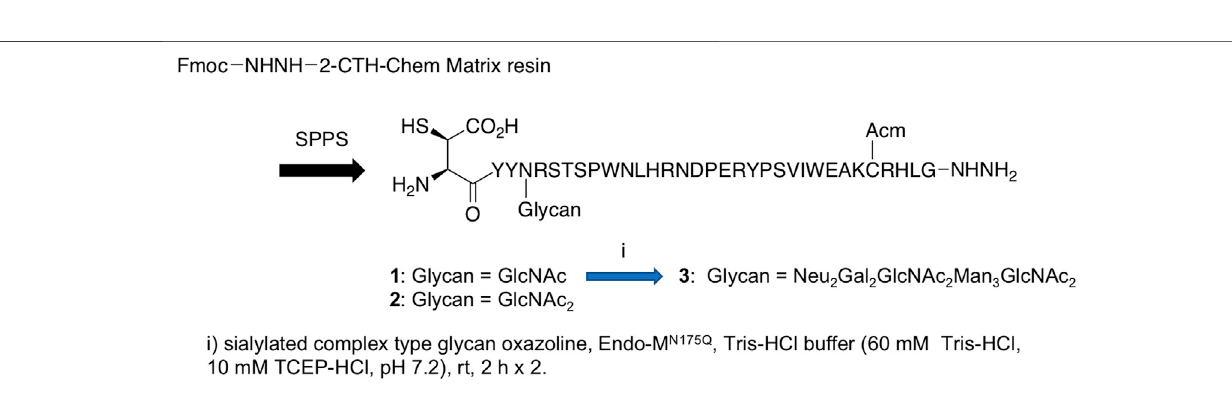
Frontiers in Chemistry |